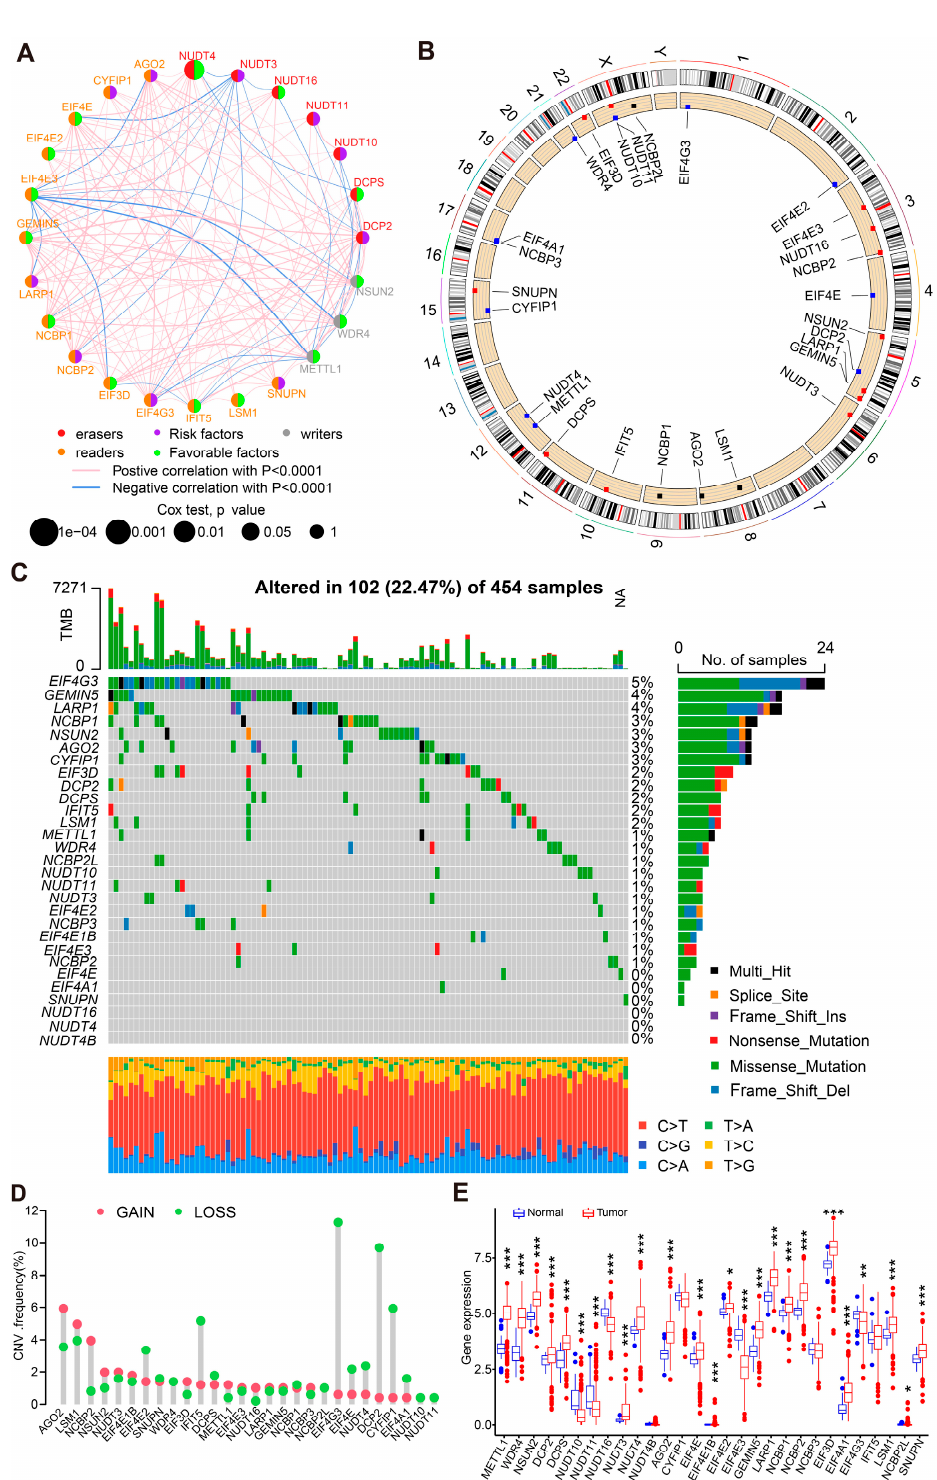
Figure 1. Genetic alterations and expression of the 29 m7G-related genes in CC patients. ( A ) Expres- sion modification of m7G-related genes and their effect on regulation. ( B ) Gene location on chromo- some with mutation information. Blue dots indicate deletion and red dots mean amplification. ( C ) Copy number variation (CNV) of m7G-related genes in CC samples; the mutation frequency is listed on the right. ( D ) Copy number of each m7G-related gene in detail. GAIN refers to copy number amplifi- cation and LOSS means copy number deletion. ( E ) The boxplot for the differentially expressed m7G- related genes between normal and CC samples. * p < 0.05, ** p < 0.01, *** p < 0.001.